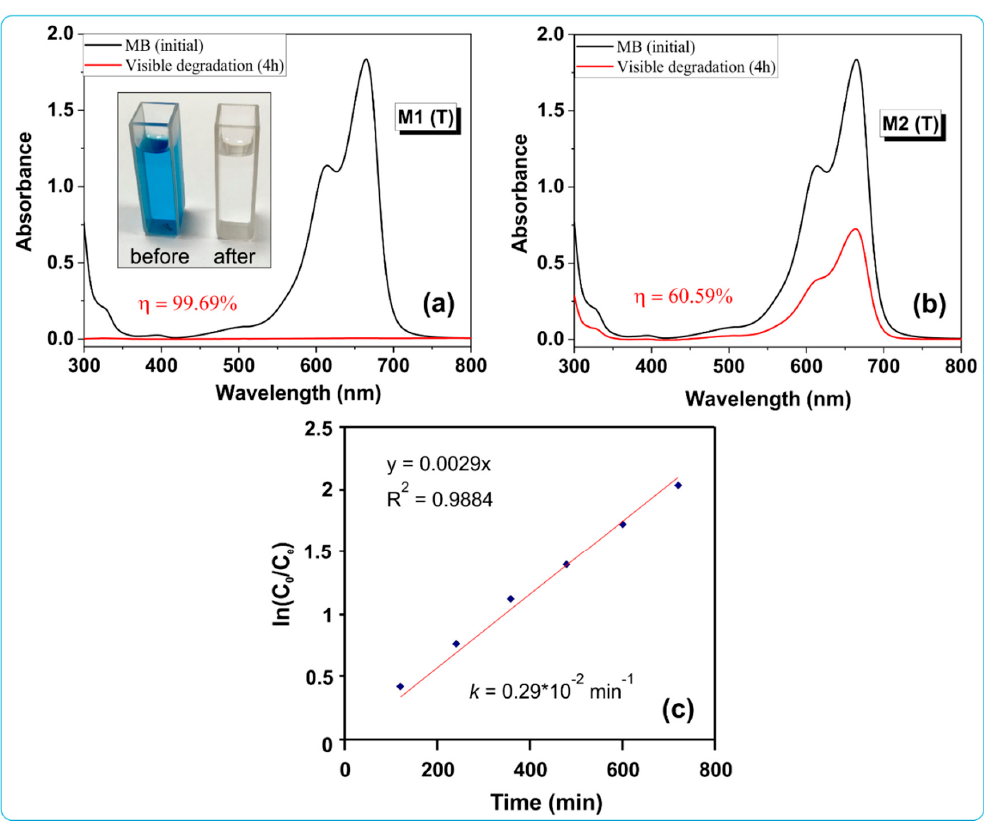
Figure 10. UV–Vis absorption spectra after visible light irradiation for 4 h in the presence of sample M1 (T) ( a ) and M2 (T) ( b ), and the degradation kinetics for M1 (T) sample ( c ).